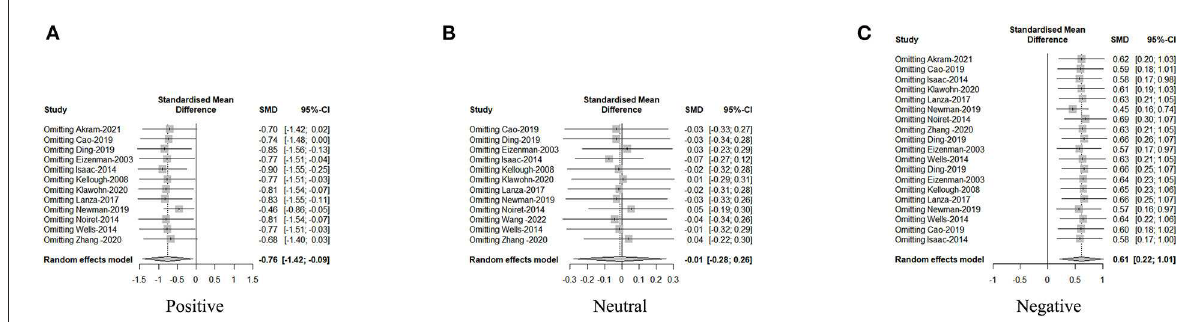
FIGURE4 Sensitivity analysis of fixation duration of positive emotional stimulus (A) , neural emotional stimulus (B) , and negative emotional stimulus (C) .